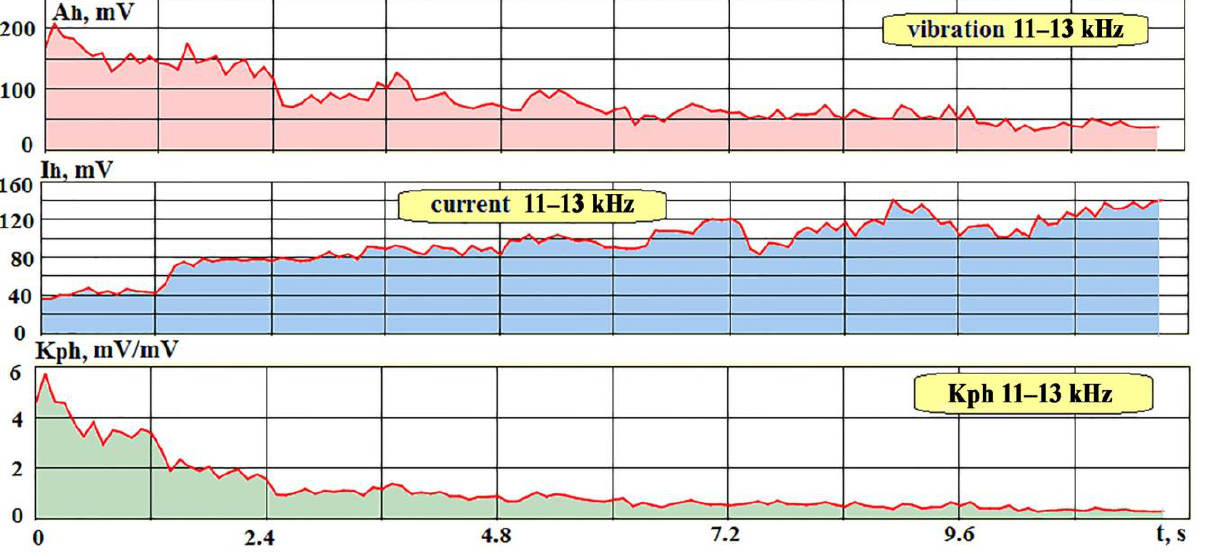
Figure 8. The procedure for constructing the transmission coefficient at high frequencies and its change from the moment of embedding to the break of the wire electrode: A h — RMS amplitude in the high-frequency range; I h — RMS amplitude of the discharge current; K p h — transmission coefficient in the high-frequency range.